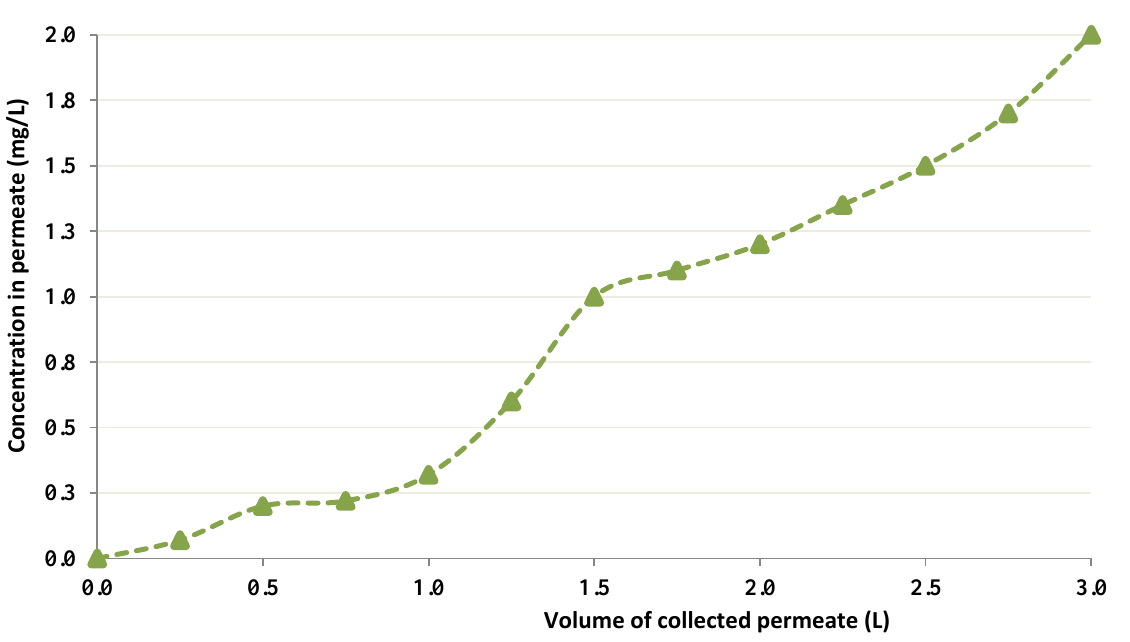
Figure 7. Permeation curve for various Chitin concentrations in CEFP.